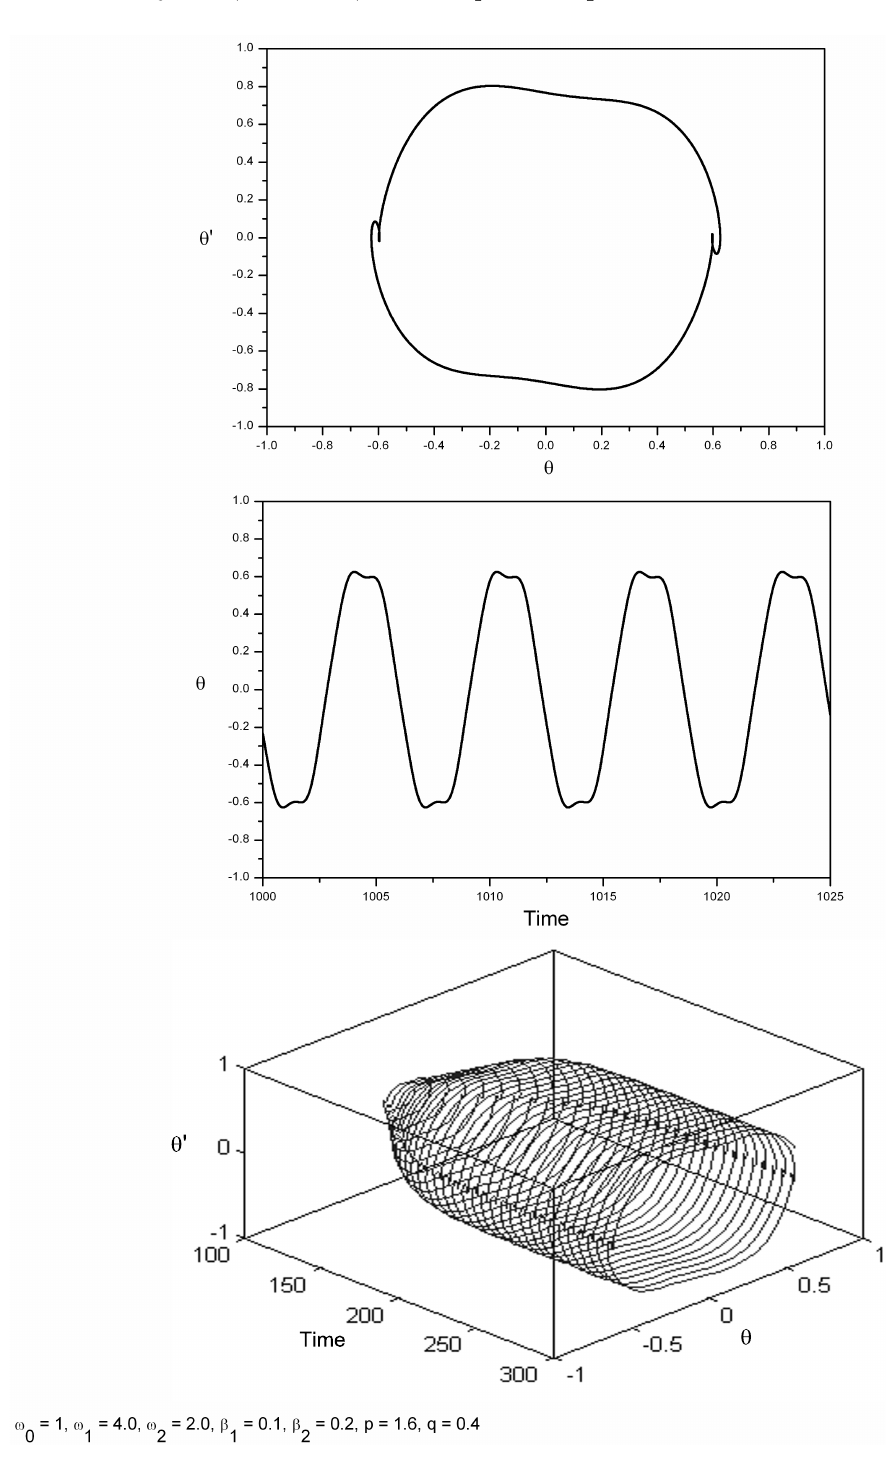
Figure 6. Evidence of double nodding when the ratio of forcing frequencies is equal to 2 : ω = 4 and ω = 2 , ω = 1 , β = 0 . 1 , β = 0 . 2 , p = 1 . 6 , q = 0 . 4 1 2 0 1 2